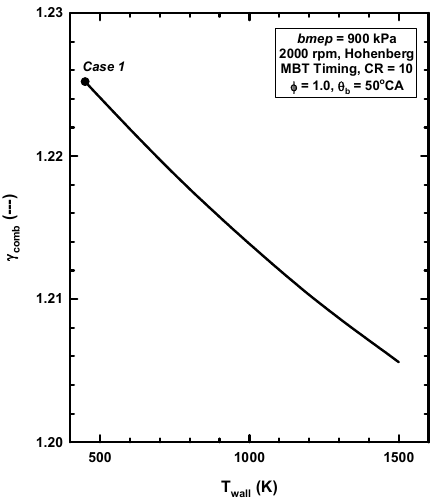
Figure 8. Average gamma during combustion as functions of cylinder wall temperature.